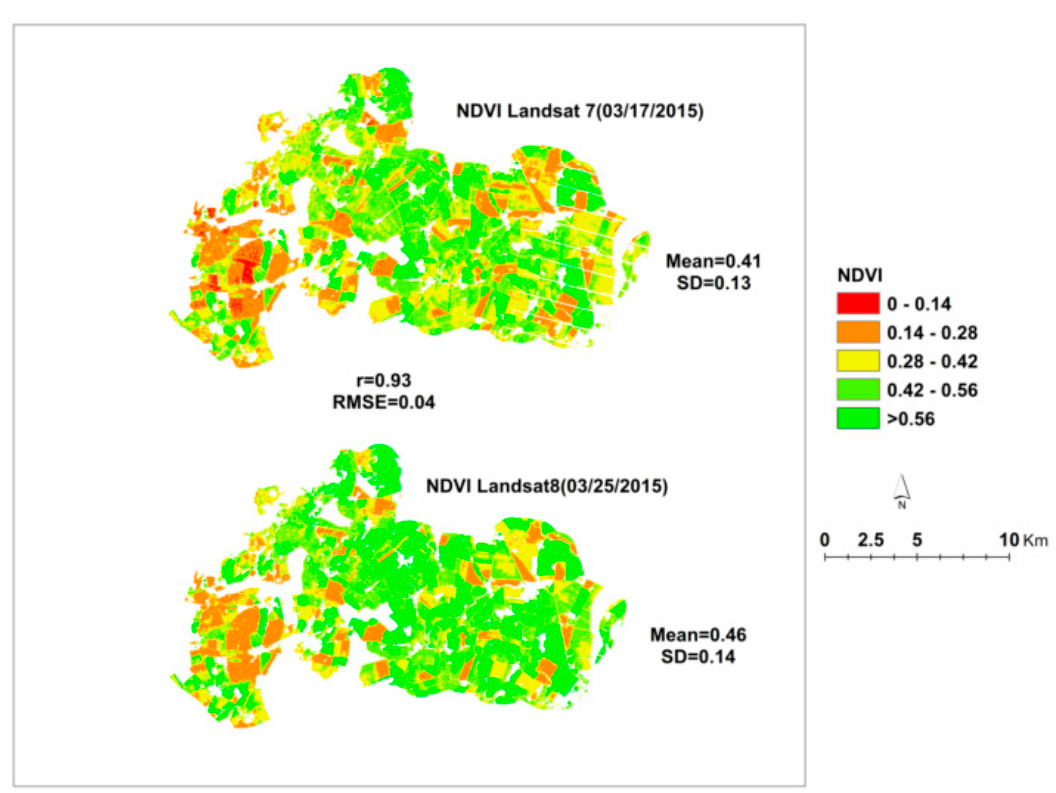
Figure A1. Comparison of NDVI values between two closely taken images from Landsat 7 and Landsat 8 satellites, indicating comparably similar distribution and